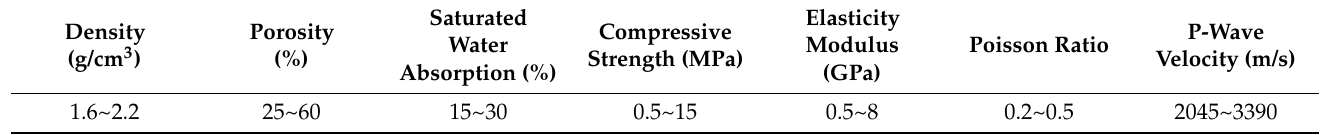
Table 1. Results of CRC physical and mechanical properties measured by